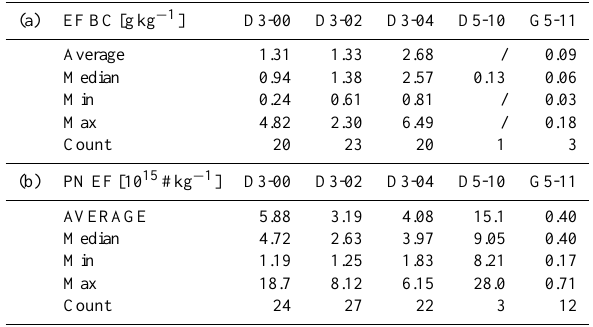
Table 2. Summarized emission factors (EFs) of individual vehicles for (a) black carbon (BC) and (b) particle number (PN).